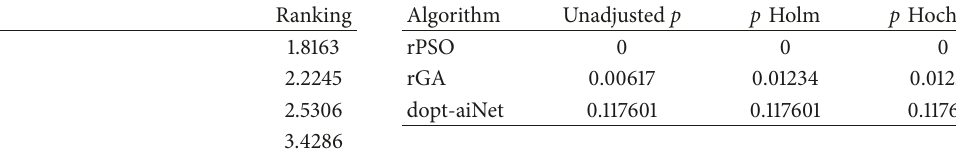
Table 21: Adjusted 𝑝 values associated with PLBA and other com- parable algorithms (Friedman) on dynamic benchmark problems